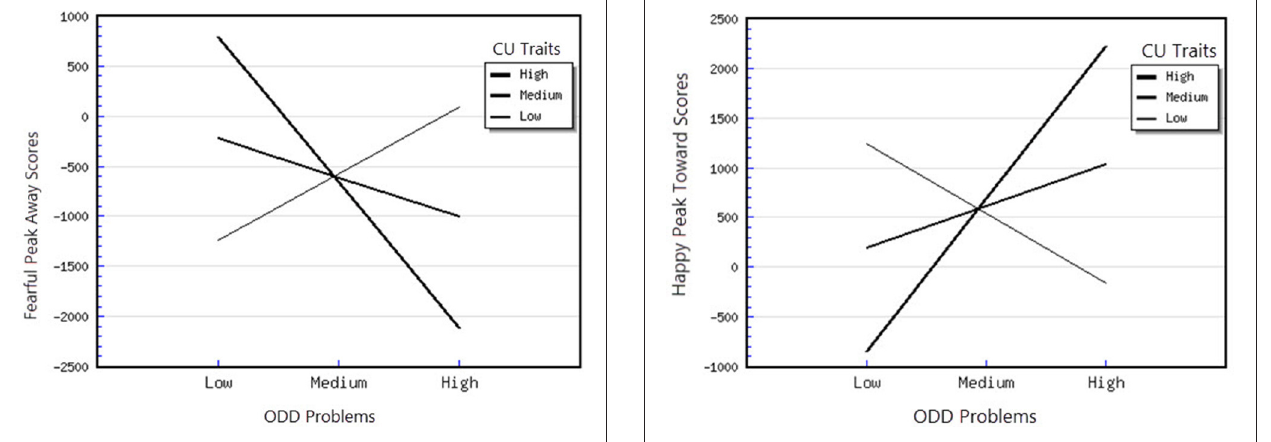
FIGURE 5 | Interaction between ODD problems and CU traits in predicting fearful peak away scores.